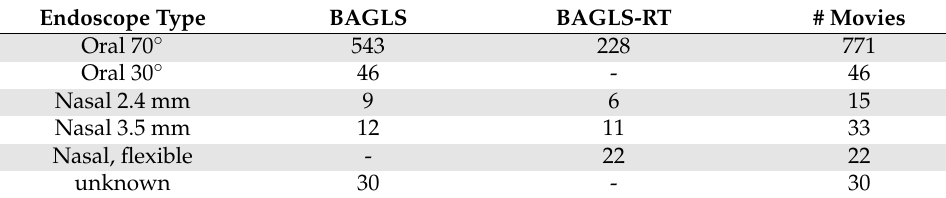
Table A5. Included endoscope types.